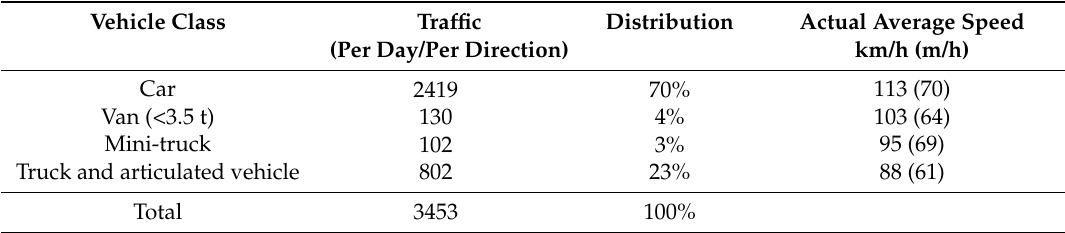
Table 2. Measured traffic for the different vehicle categories (t: metric ton) adapted from